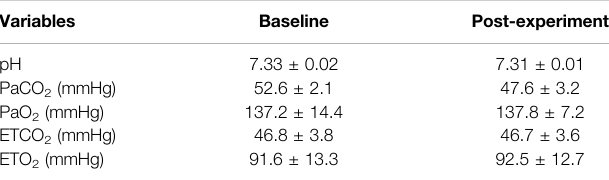
TABLE 1 | Arterial blood-gas chemistry and end tidal values ofCO 2 and O 2 before and at the end of the completed experimental protocols.